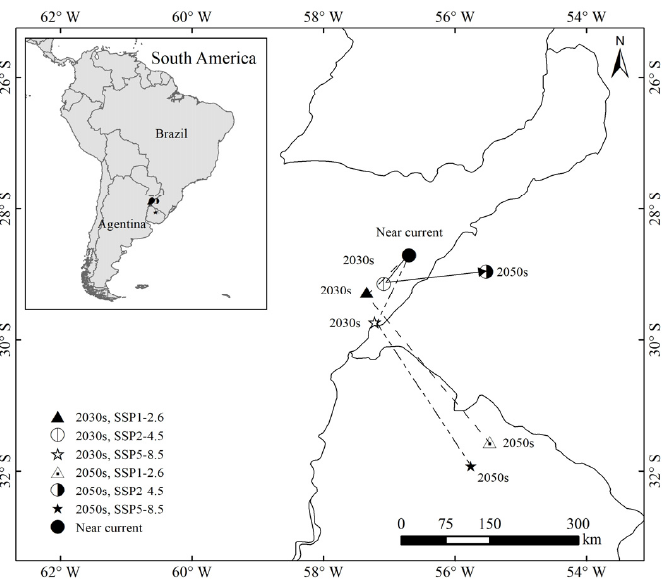
Figure 6. Distribution centroids of Phoracantha semipunctata under the near current and future climate scenarios.